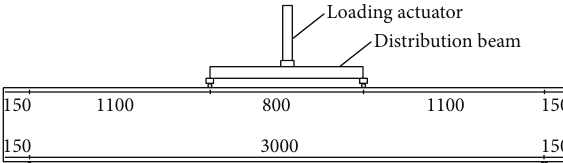
Figure 2: Experimental beam loading